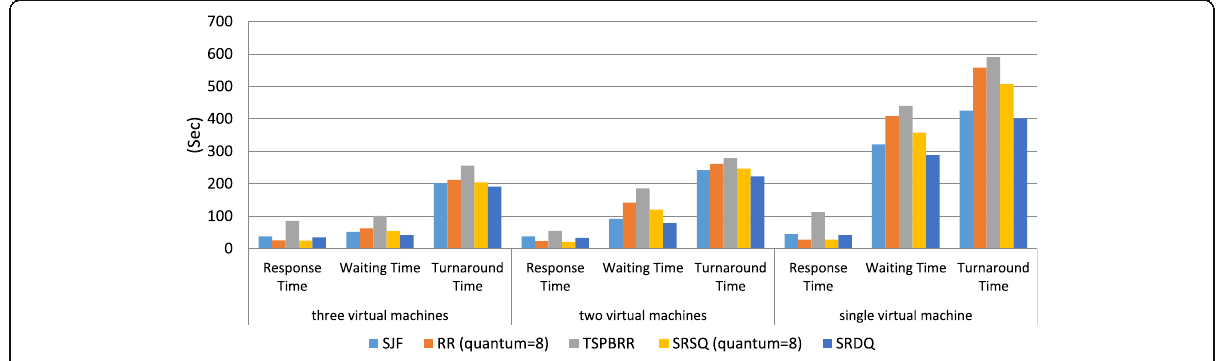
Fig. 3 Third Experimentation Results using Dataset3, on (1,2,3)